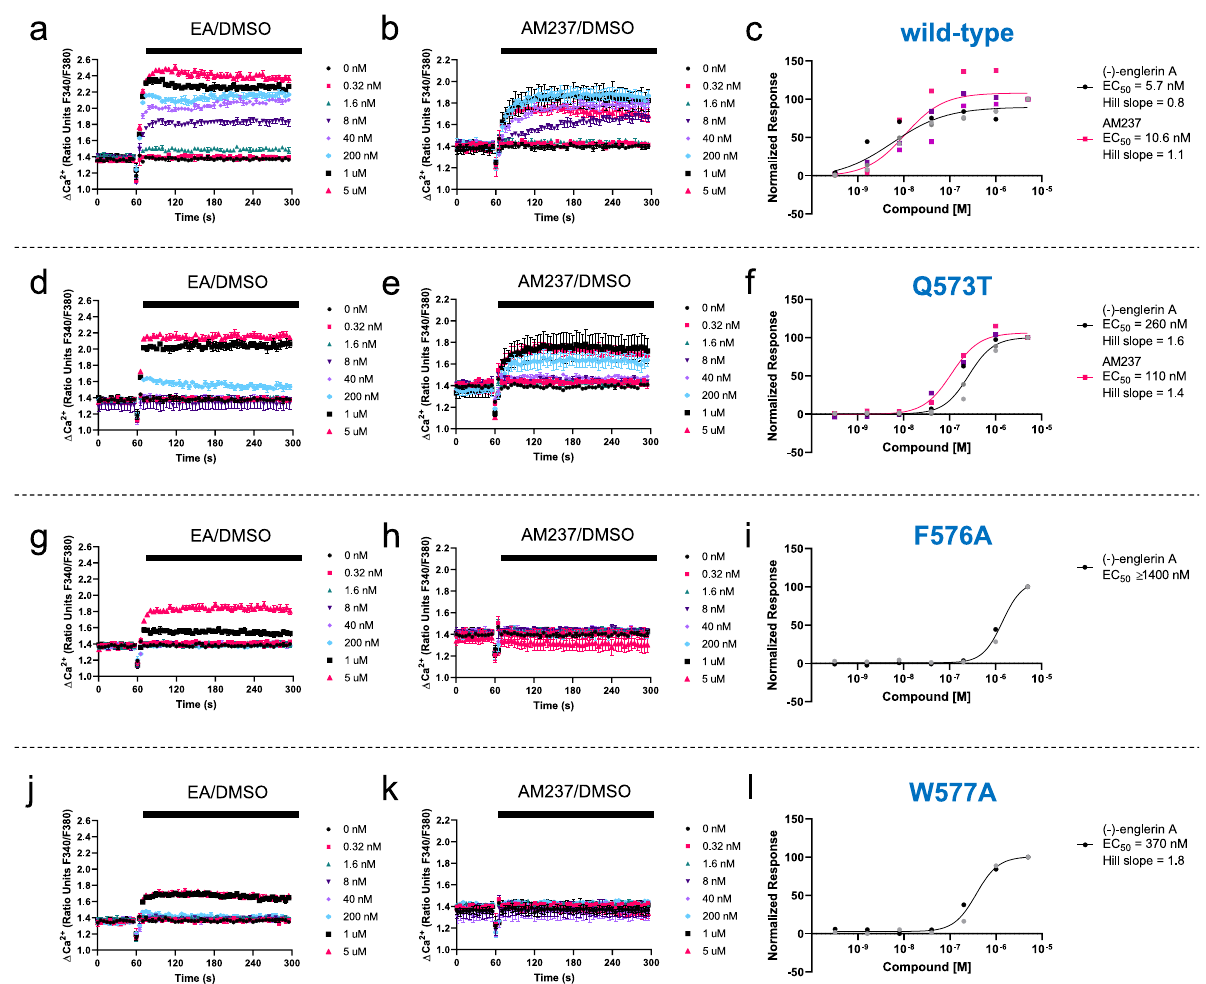
Representative traces from single 96-well plates ( N = 3; error bars show standard deviations over technical replicates) showing changes of [Ca 2 + ] i in response to 0.32 nM to 5 µ M of EA ( a , d , g , j ) or AM237 ( b , e , h , k ) in HEK 293 cells transiently expressing wild-type TRPC5-SYFP2 ( a , b ),